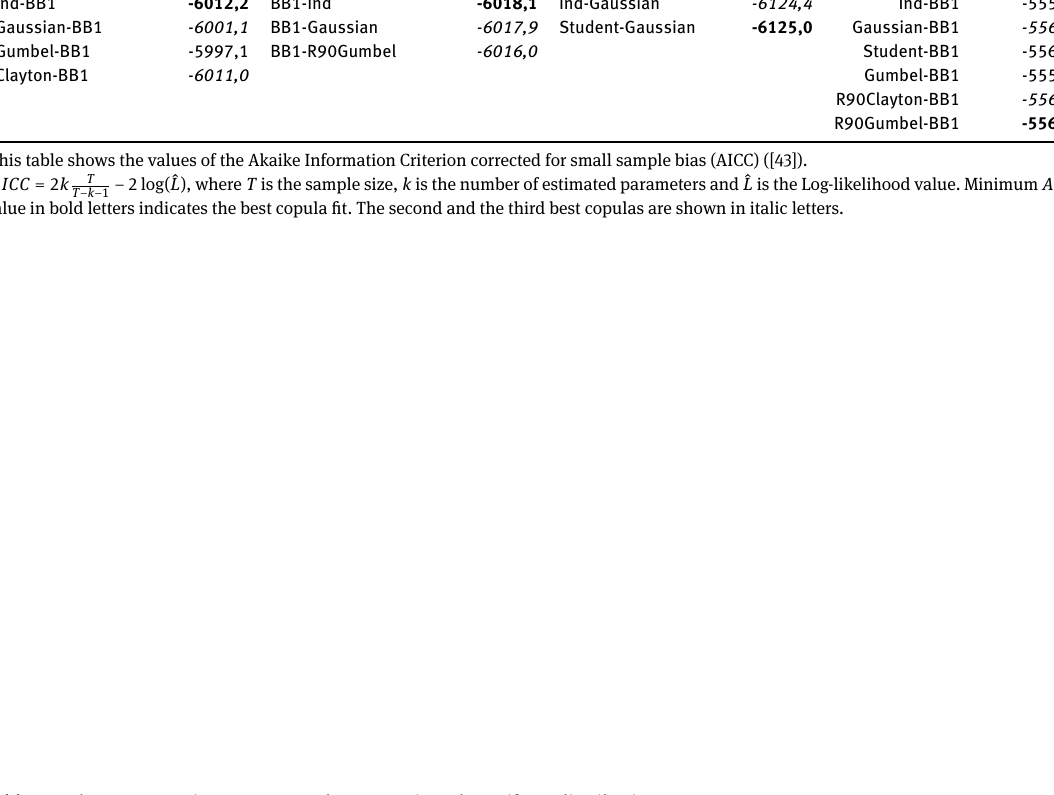
Table 7: Kolgomorov Smirnov one sample test against the uniform distribution A B C D